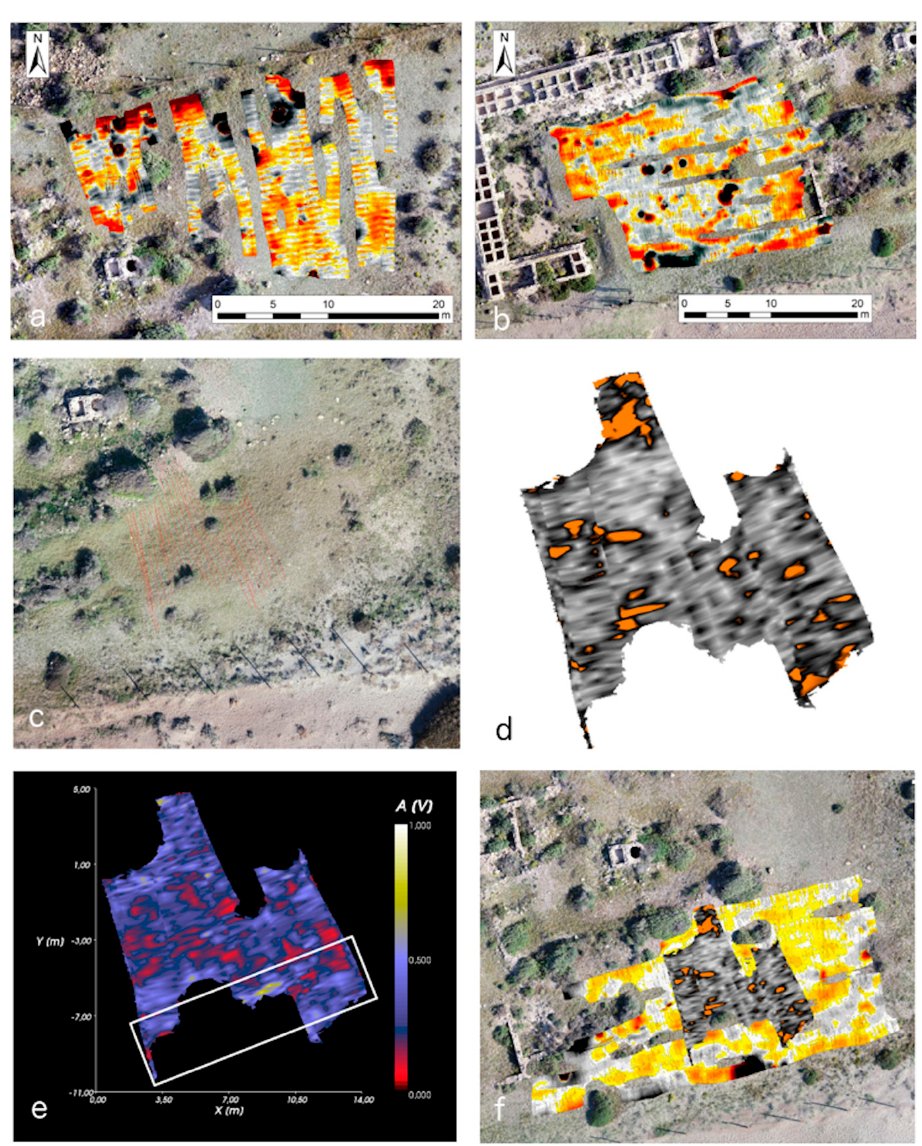
Figure 16. Details of GPR and Magnetometer scan results. Potential southern enclosure wall of the complex marked by white square.